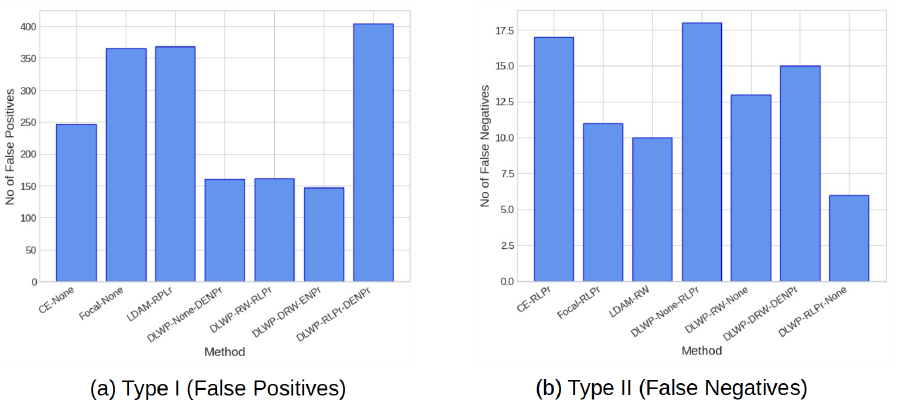
Figure 5. ( a ) Type I and ( b ) Type II errors from all best-in-category methods evaluated on APS Failure at Scania Trucks